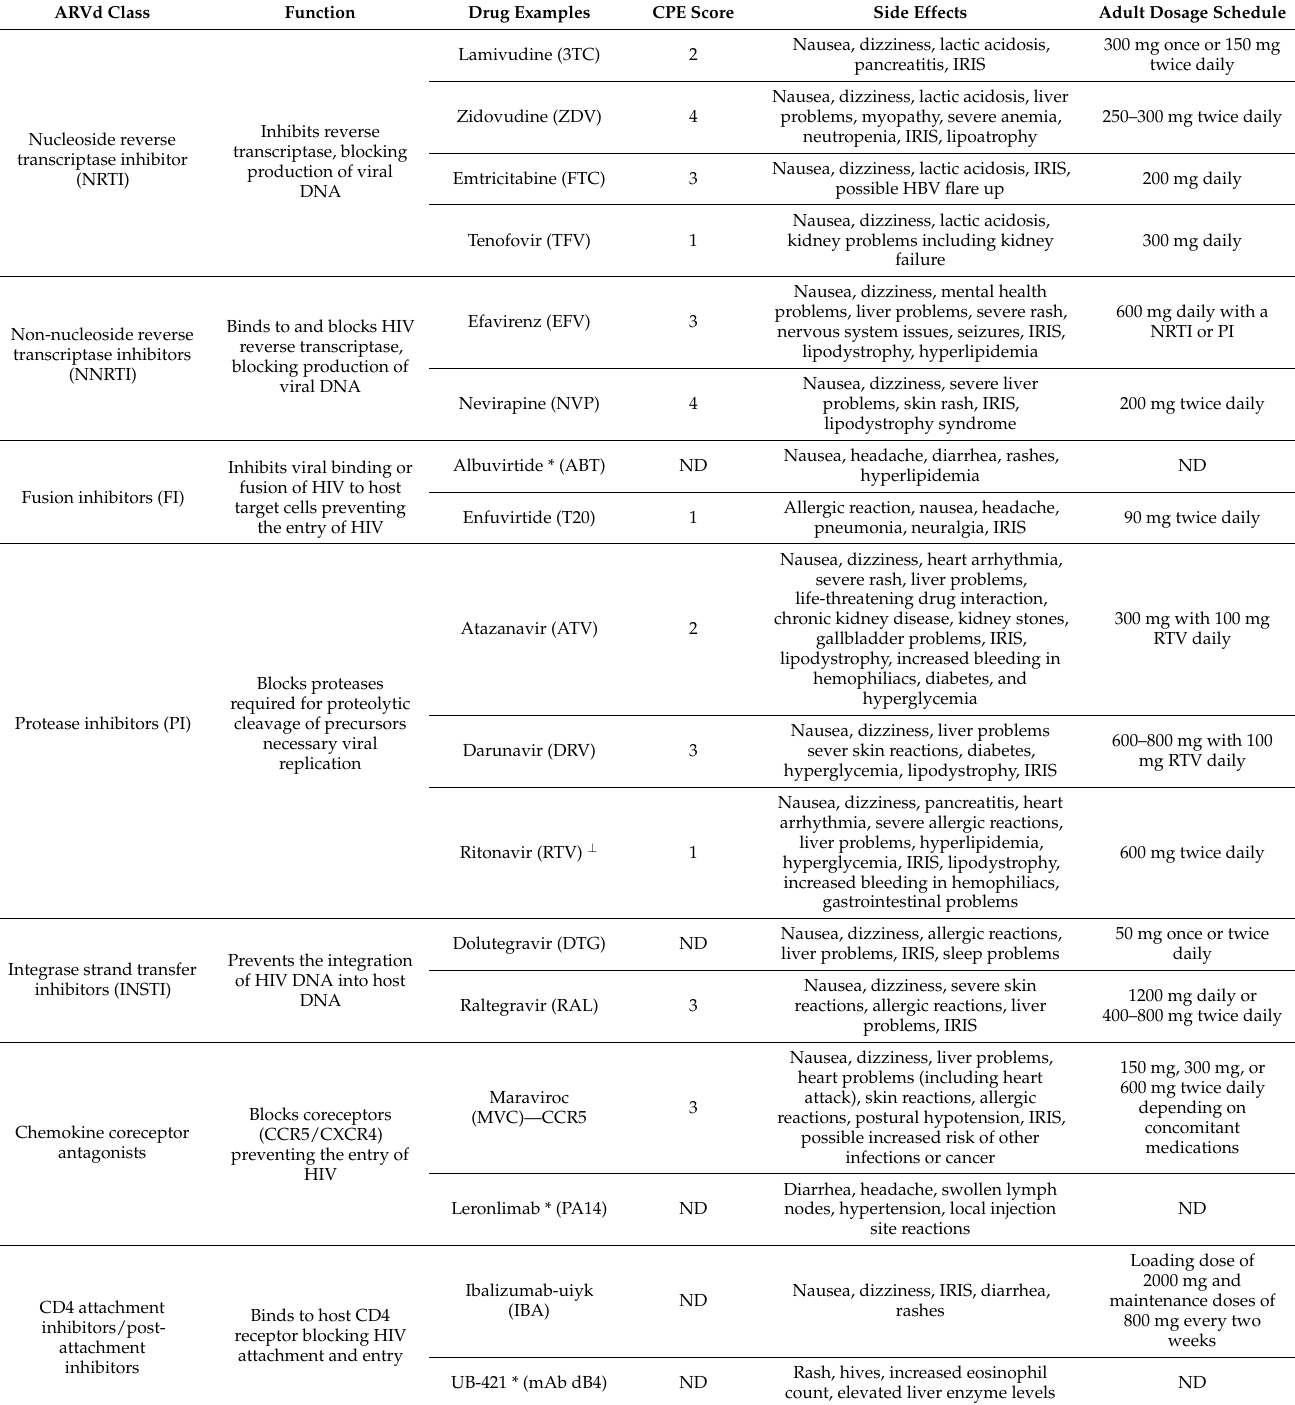
Table 1. Antiretroviral drug classes, function, examples, and dosage